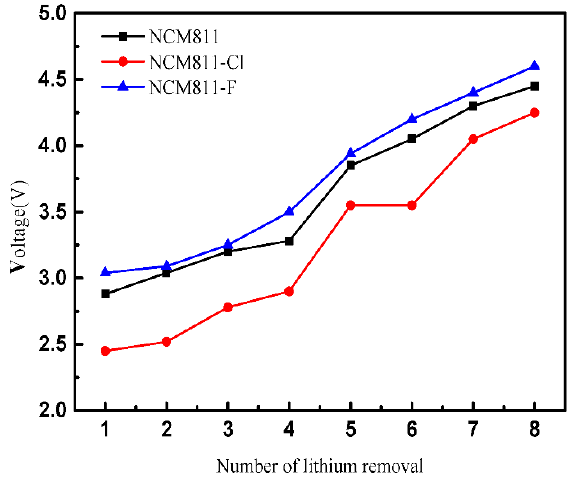
Figure 5. Delithiation potential in the process of delithiation.